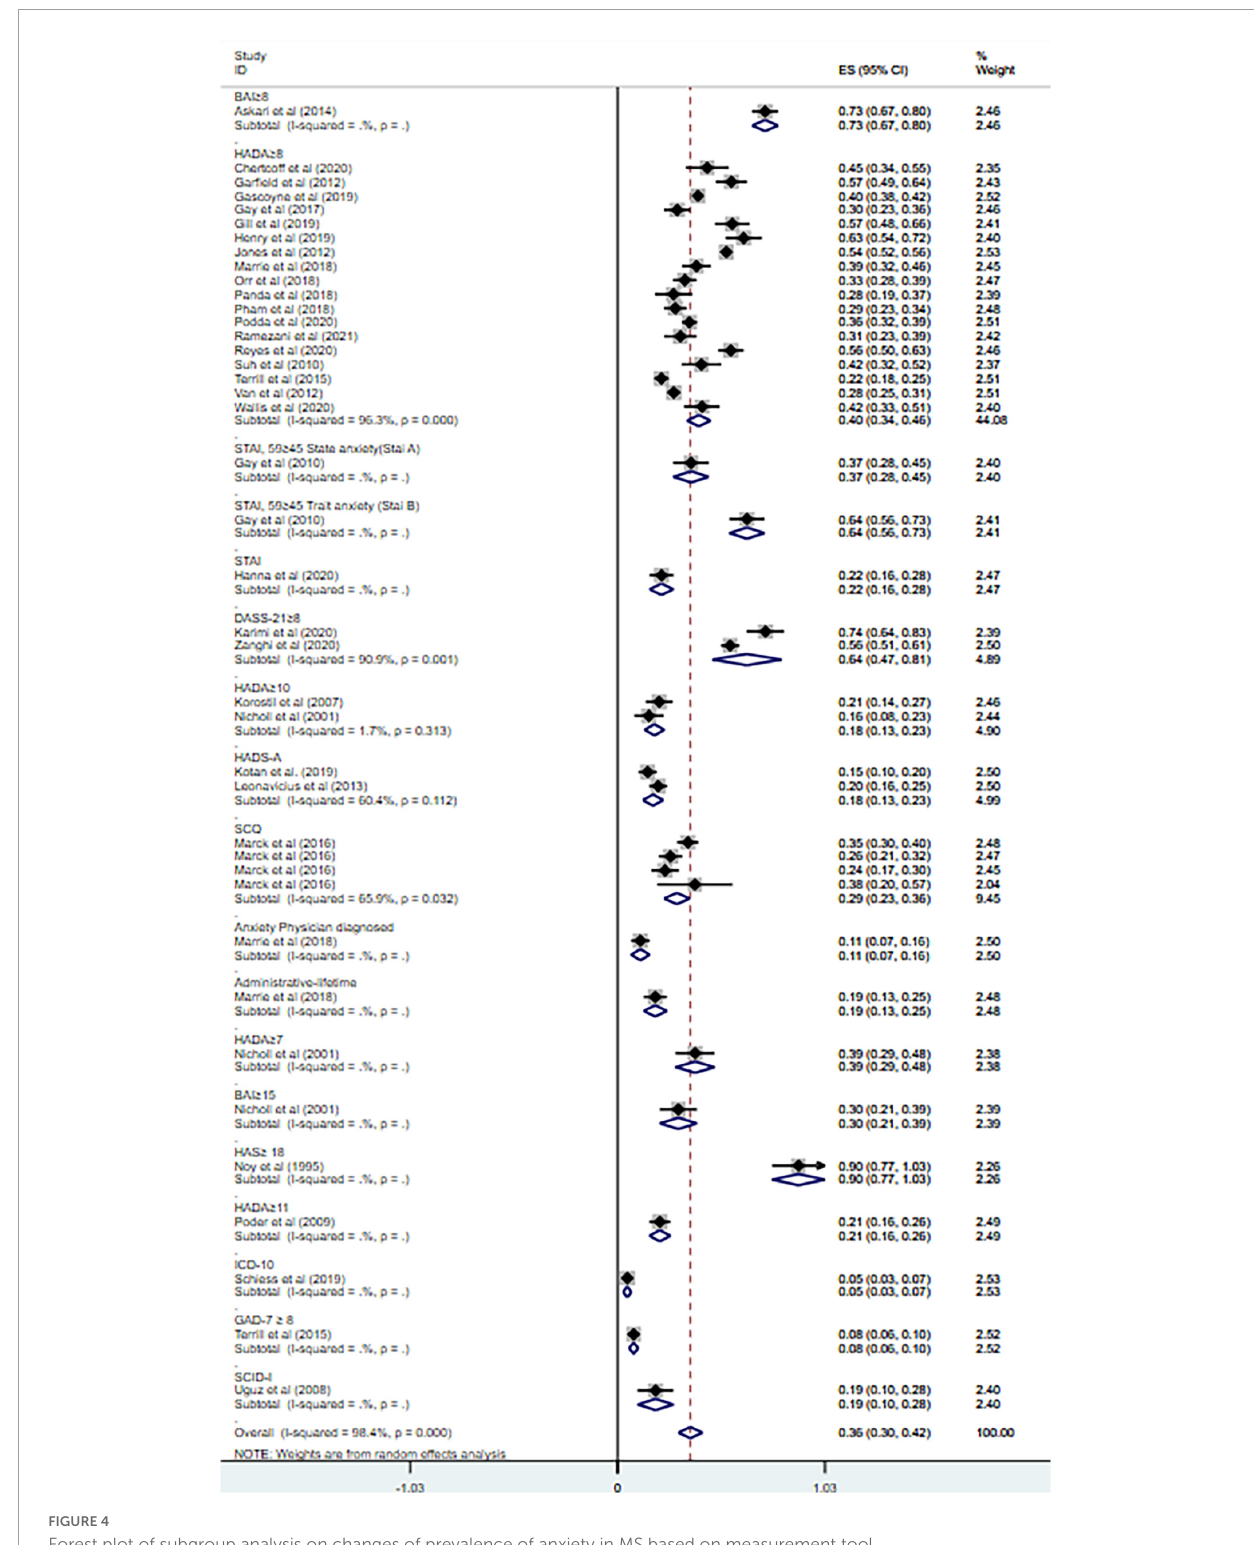
FIGURE4 Forest plot of subgroup analysis on changes of prevalence of anxiety in MS based on measurement